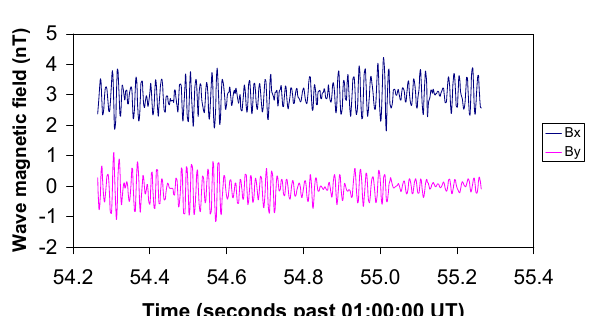
Fig. 2. Scatter plot of DC magnetic field magnitude versus lion roar frequency.